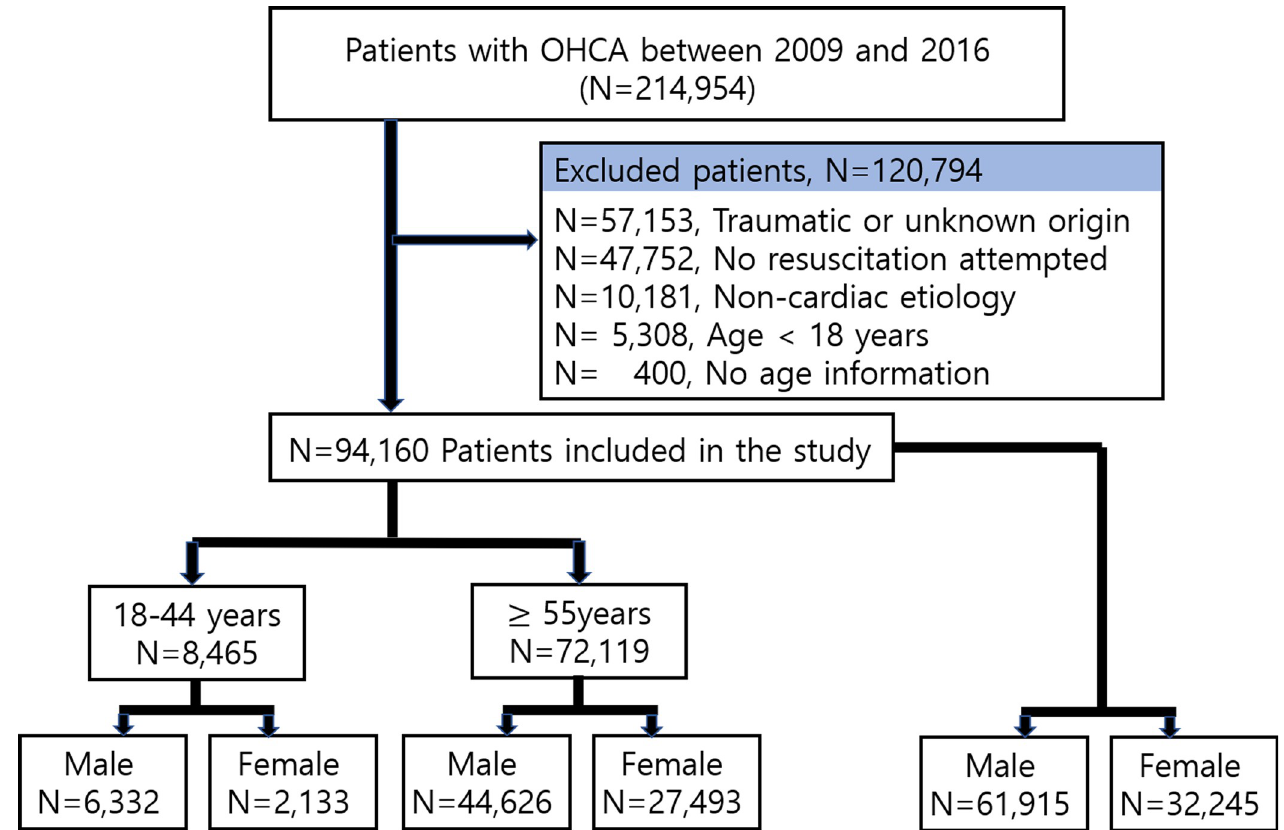
Fig 1. Inclusion and exclusion flow chart. We had excluded patient step by step from top to above. https://doi.org/10.1371/journal.pone.0258673.g001 CPR and prehospital defibrillation, than men. In the age group of 55 years and above, women were older, more likely to experience OHCA at home, less likely to be witnessed, have an initial shockable rhythm, and receive bystander CPR and prehospital defibrillation, than men (Table 2).